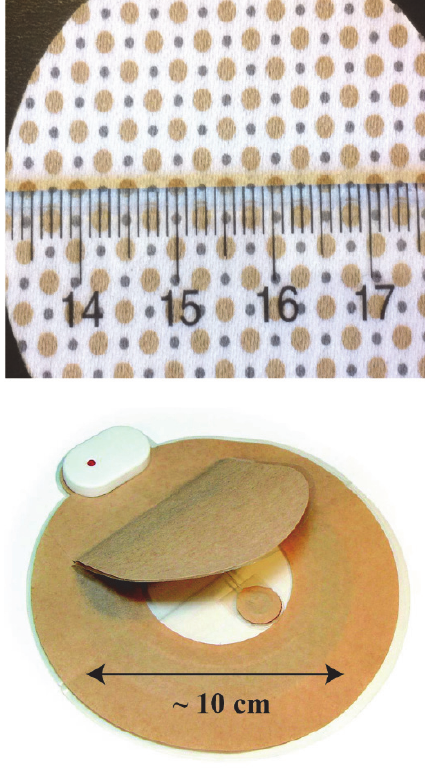
Fig.1: (top) Close-up of a Procellera ® dressing. Large dots are Ag and the small dots are Zn. (bottom) A POSiFECT ® dressing. For further information we refer to references [25, 27, 28]. Both scales are in